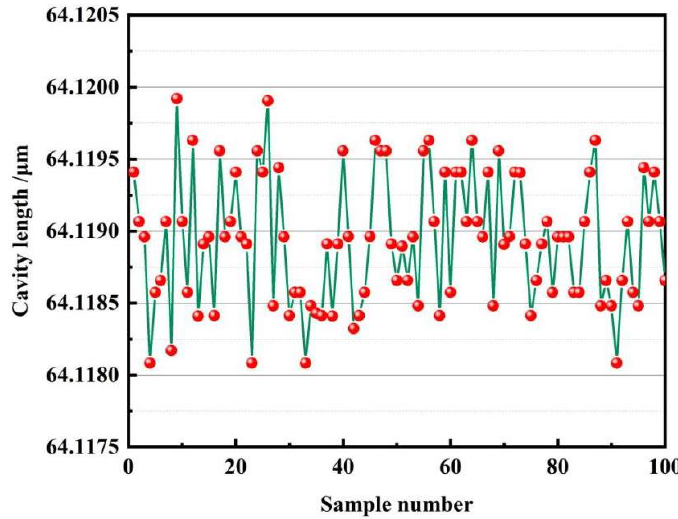
Figure 8. Repeated measurement of a fiber-optic FP sensors for 100 times.